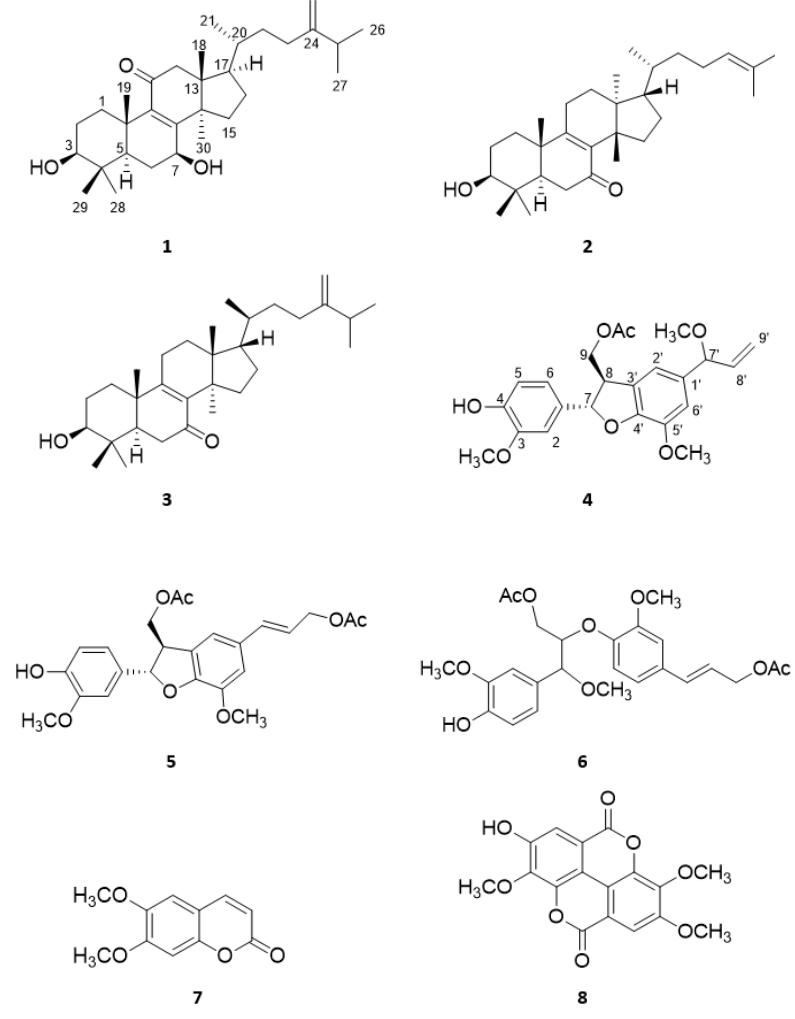
Figure 1. Compounds isolated from E. deightonii ( 1 – 8 ). Table 3. Cytotoxic (CC 50 ) and antiviral activity (IC 50 ) of compounds 1 – 8 . For determination of CC 50 concentration, Vero cells were seeded at a density of 4 × 10 4 /well. After incubating overnight, the medium was replenished with medium containing two-fold dilutions of each compound. Twenty-four hours later, MTT assay was carried out. The antiviral activity was expressed as IC 50 in µ M.